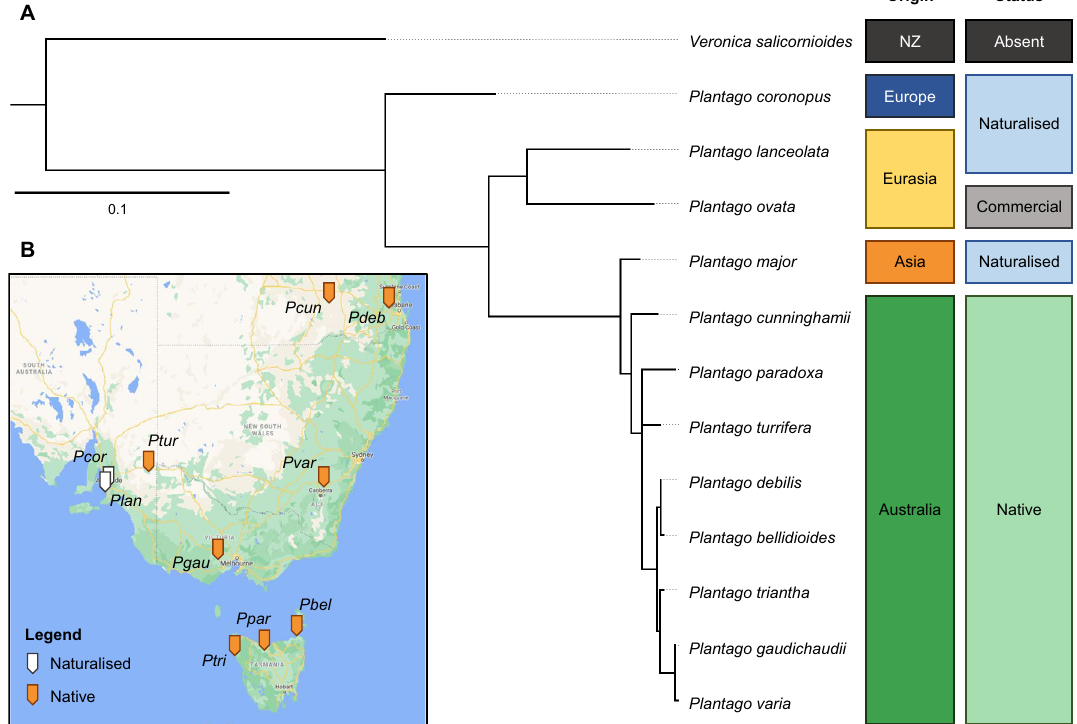
Figure 1. ( A ) Maximum-likelihood tree of nuclear ribosomal DNA internally transcribed spacer (ITS) regions of Plantago species studied here. The ITS sequence of Veronica salicornioides , a New Zealand (NZ)-endemic relative in Plantaginaceae, is included as the outgroup. Noted alongside each species are their geographic origin (where native to) and the status of occurrences in Australia (naturalised, native or grown commercially). Scale refers to substitutions per site. ( B ) Locations of Plantago sources in South Eastern Australia based on coordinates supplied with seedbank-withdrawn accessions or collection sites. Map sourced from Google Earth earth.google.com/web. P. ovata and P. major samples were purchased commercially, so origin information can only be assumed. Abbreviations: Pbel = P. bellidioides ; Pcor = P. coronopus ; Pcun = P. cunninghamii ; Pdeb = P. debilis ; Pgau = P. gaudichaudii ; Plan = P. lanceolata ; Ppar = P. paradoxa ; Ptri = P. triantha ; Ptur = P. turrifera ; Pvar = P.